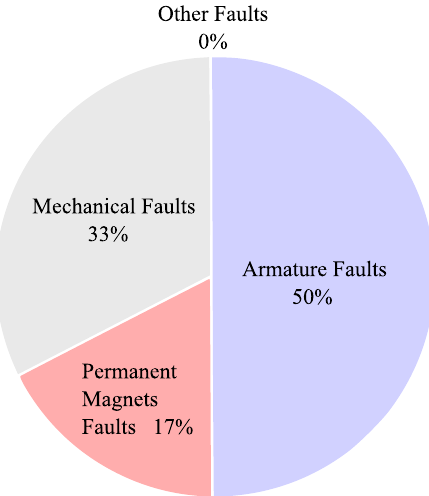
Figure 4. Distribution of the papers according the type of failure